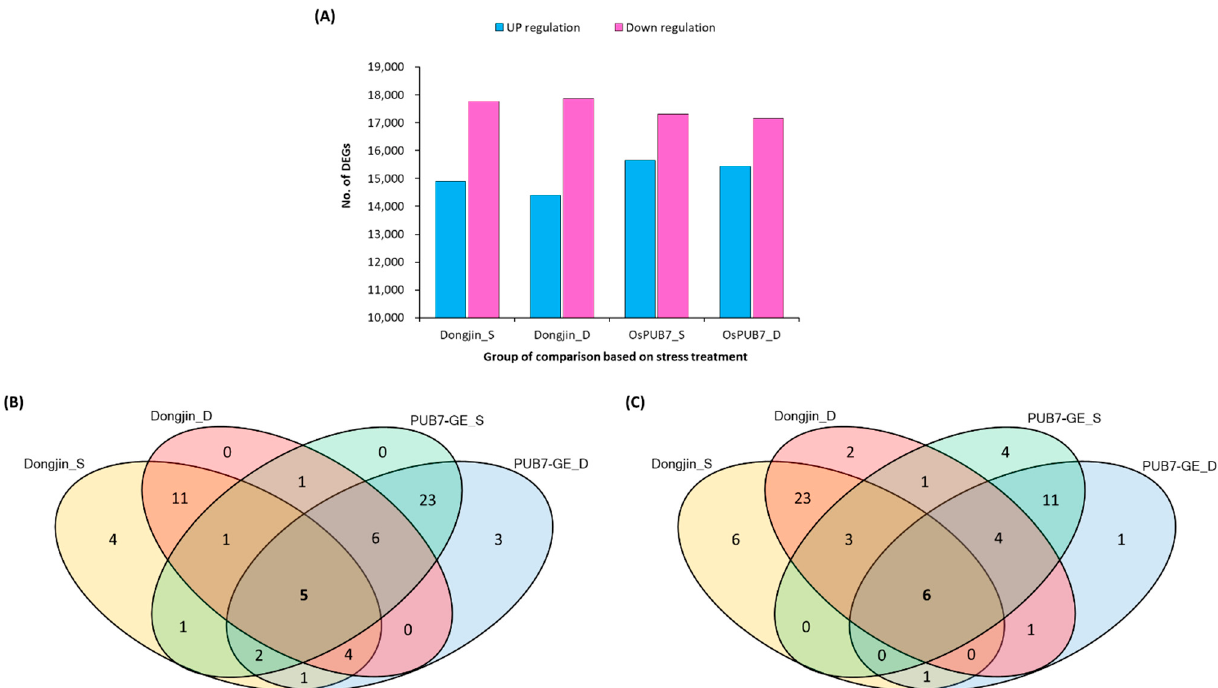
Figure 14. Comparative analysis of differentially expressed genes (DEGs) after drought and salinity stress treatment. ( A ) Number of down-regulated and up-regulated DEGs in samples in response to stress treatment. ( B ) Venn diagram of down-regulated genes in PUB7-GE (K343-8-1) vs. WT ( Dongjin ). ( C ) Venn diagram of up-regulated genes in PUB7-GE (K343-8-1) vs. WT ( Dongjin ).